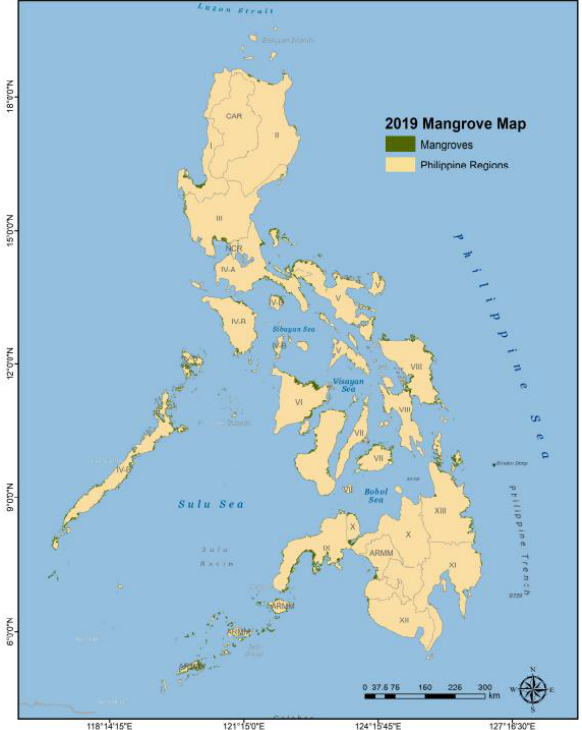
Figure 1. MVI-based 2019 Mangrove Extent Map of the Philippines (Baloloy et al.,